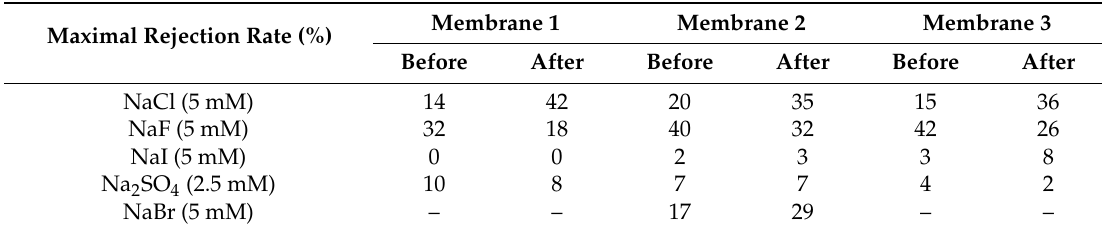
Table 4. Maximal rejection rates obtained with membranes 1, 2 and 3 for all the studied solutions before and after the alkaline